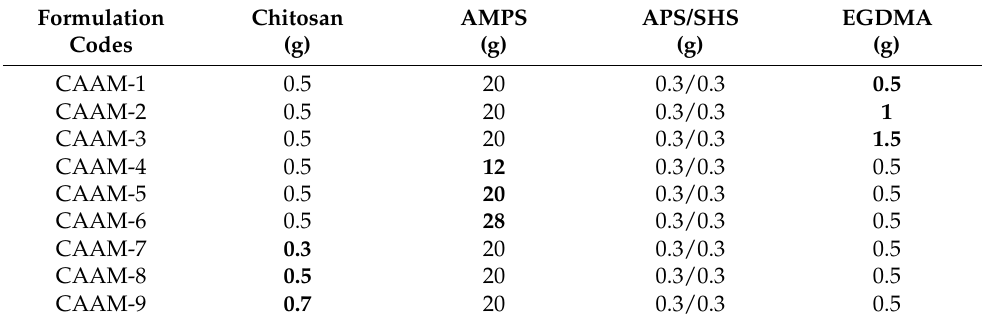
Table 4. Feed composition of different formulations of CS- g -AMPS hydrogels per 100